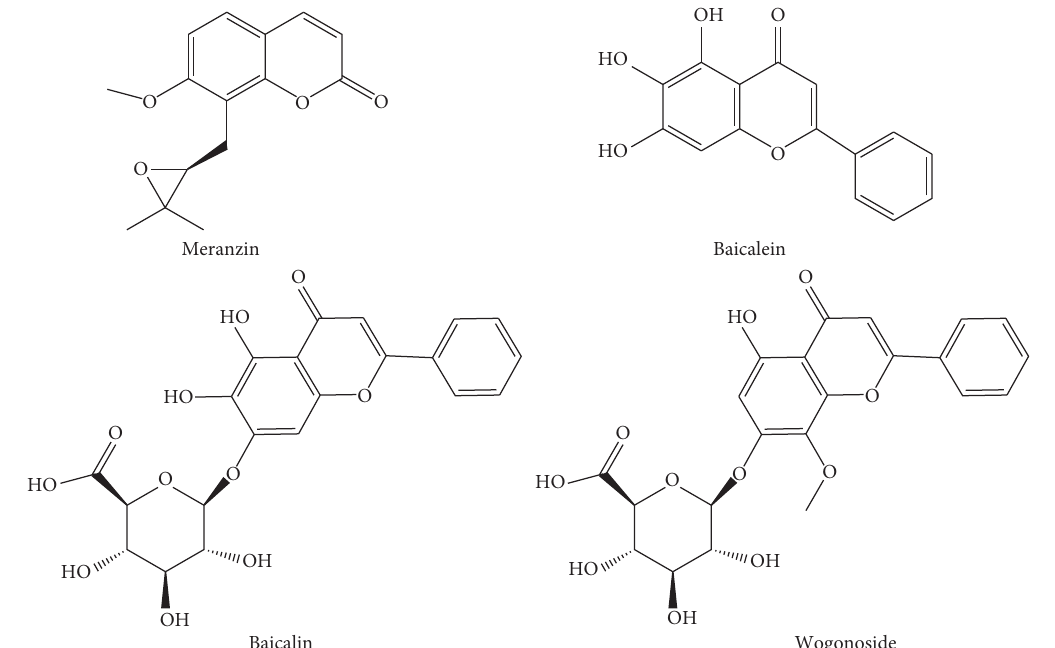
Figure 6: Chemical structures of meranzin, baicalin, baicalein, and wogonoside.